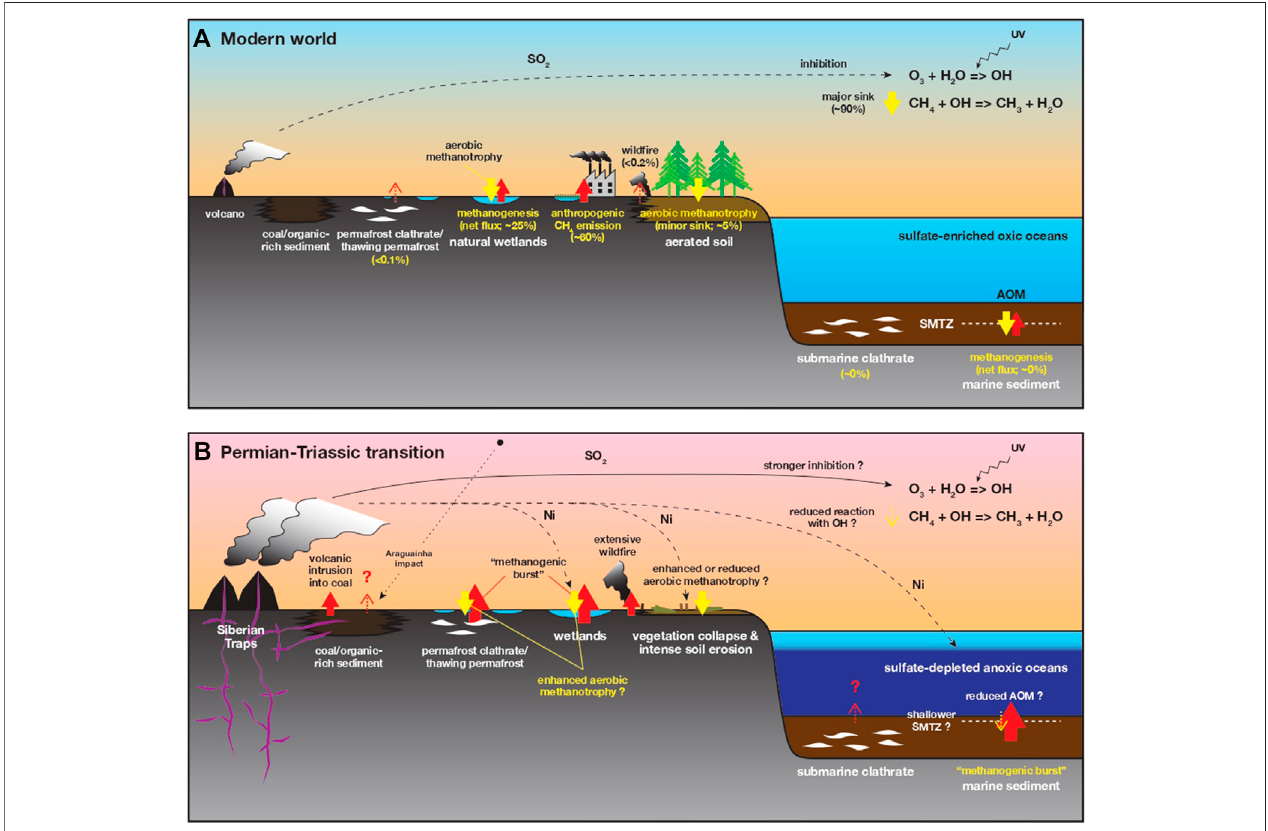
FIGURE 8 | Schematic diagram of the global CH 4 cycle in the modern world (A) and during the Permian-Triassic transition (B) . CH 4 in fl ux to and ef fl ux from the atmosphere are shown as red and yellow arrows, respectively. In the modern system, the global atmospheric CH 4 budget is 0.4 – 0.5 Gt C/year (Supplementary Information;e.g.,Conrad,2009;Nazariesetal.,2013).DuringthePermian-Triassictransition,severalprocessesmayhavecontributedtotheelevated p CH 4 andclimate warming, althoughterrestrialresponsestotheelevated p CH 4 wereprobably complex. The elevated p CH 4 enhanced aerobicmethanotrophyin localsoils whereas the intense soil erosion decreased a net CH 4 ef fl ux in the global budget. AOM: anaerobic oxidation of methane; SMTZ: sulfate-methane transition zone. See Supplementary Information for details.